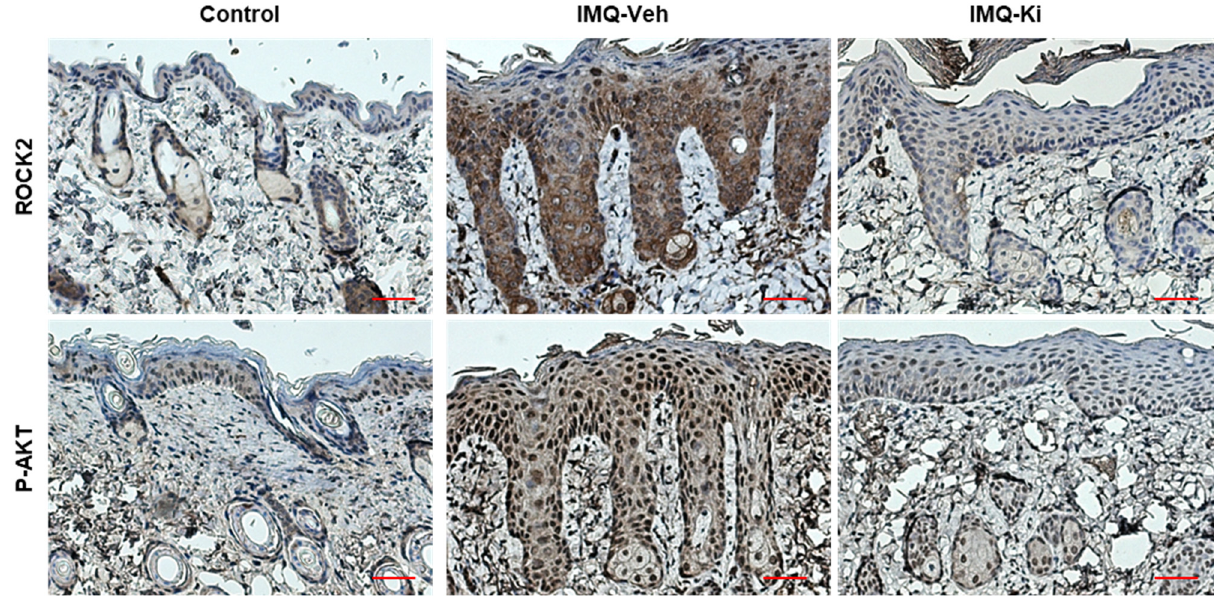
Figure 7. Ki16425 decreases the epidermal expression of ROCK2 and p-AKT in IMQ-induced psoriasis-like mice. Im- munohistochemical detection of ROCK2 and p-AKT was performed in the skin tissues using the specific antibodies and DAB staining kit. The nuclei were counterstained with hematoxylin. The representative images are depicted (original magnification, 200×, n = 3/group). Scale bars: 50 μ m.